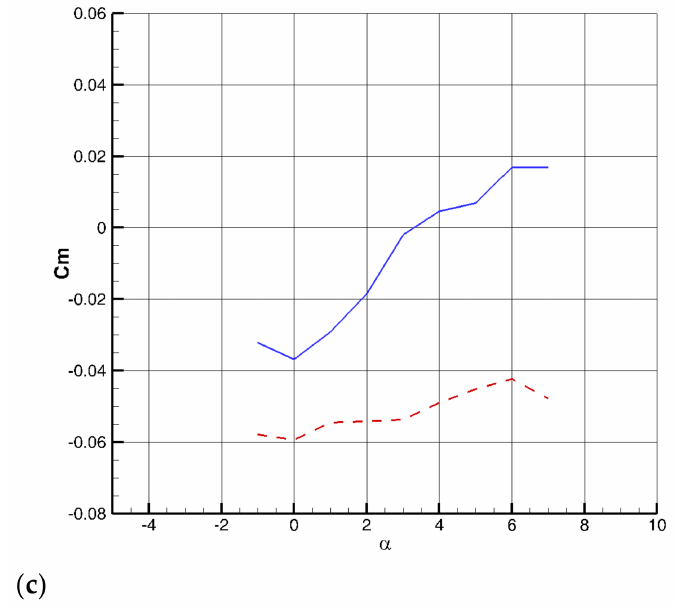
Figure 15. Comparison of the initial and optimized airfoil of wing-body in the presence of PVG in M = 0.87, h = 30,000 ft: ( a ) C L − α diagram; ( b ) C D − α diagram; ( c ) C m − α